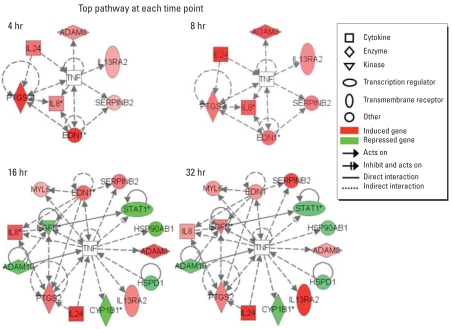
Pathway analysis of genes differentially expressed at each of the four time points. At 4 and 8 hr of Cd treatment, genes exhibited in the top pathway were the same eight genes confirmed by real-time RT-PCR (Figure 5). With longer Cd exposure at 16 and 32 hr, the top pathway exhibited the same pattern as shown in Figure 4C. The brighter the color of the gene, the higher the fold changes.